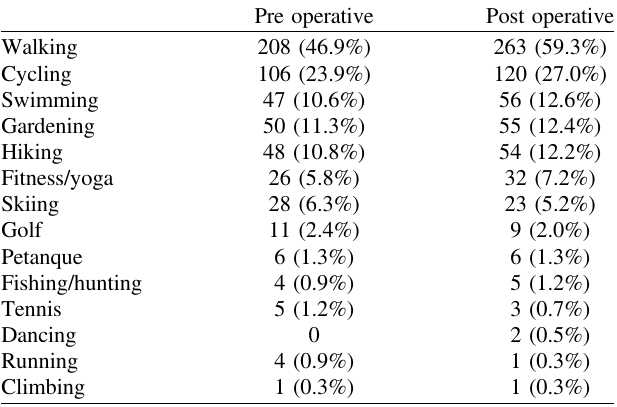
Table 2. Variation in types of sport